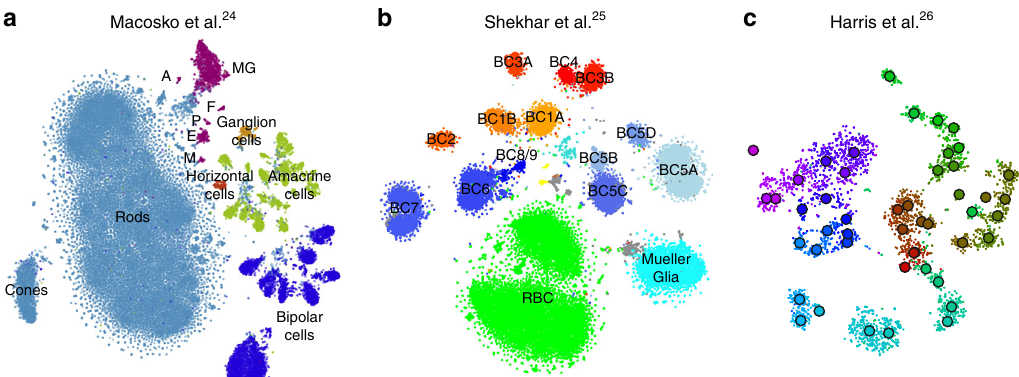
Fig. 4 UMI-based data sets. Cluster assignments and cluster colours are taken from the original publications. a Macosko et al. 24 , n = 44,808 cells from the mouse retina. Bipolar cells comprise eight clusters, amacrine cells comprise 21 clusters. Non-neural clusters are abbreviated (MG Mueller glia, A astrocytes, F fi broblasts, P pericytes, E endothelium, M microglia). b Shekhar et al. 25 , n = 27,499 cells from the mouse retina, mostly bipolar cells. BC bipolar cell, RBC rod bipolar cell. Putative doublets/contaminants shown in grey. Yellow: rod and cone photoreceptors; cyan: amacrine cells. Some clusters appear to consist of two parts; this is due to an experimental batch effect that we did not remove. c Harris et al. 26 , n = 3663 hippocampal interneurons. Circles denote cluster centroids. The centroid of one cluster ( Sst Cryab ) is not shown because its cells were scattered all over the embedding (as they did in the original publication as well). Cluster labels not shown for visual